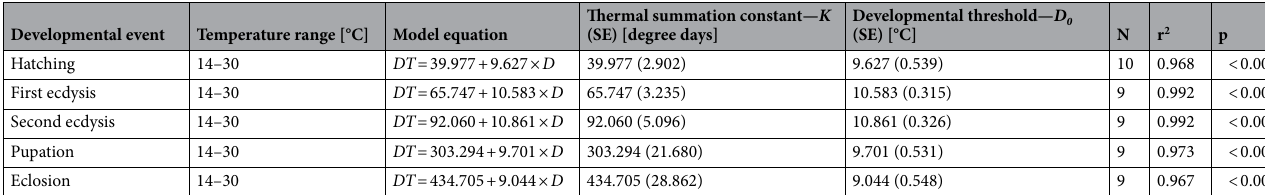
Table 3. Thermal summation models for five developmental events of N. littoralis calculated using Ikemoto and Takai method.